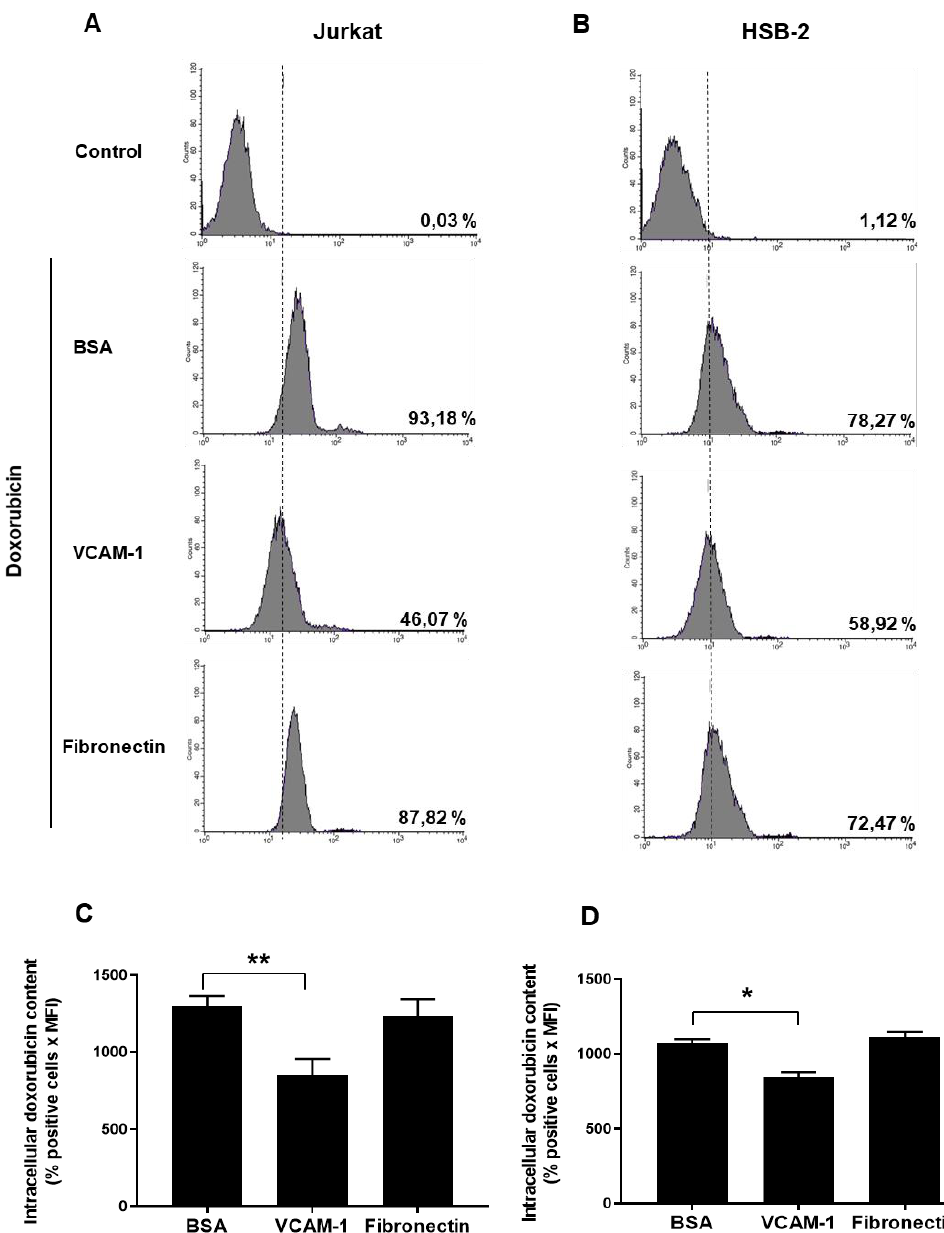
Figure 4. VCAM-1 but not fibronectin enhances doxorubicin efflux in human T-ALL cell lines. Jurkat and HSB-2 cells were seeded on VCAM-1, fibronectin or BSA for 4 h. The non-adherent cells were removed by washing with RPMI medium and the remaining cells were treated for 2 h with 100 ng/mL of doxorubicin. The cells were then washed and intracellular doxorubicin content was analyzed by FACS using the FL-2 channel. ( A , B ) Representative FACS profiles of intracellular doxorubicin content in Jurkat and HSB-2 cells. ( C , D ) Quantification of intracellular doxorubicin content in Jurkat and HSB-2 cells was determined by the percentage of doxorubicin-positive cells x MFI. Results represent mean values ± S.D. of three independent experiments. * p < 0.05 and ** p < 0.01 were determined by the Student’s t -test.